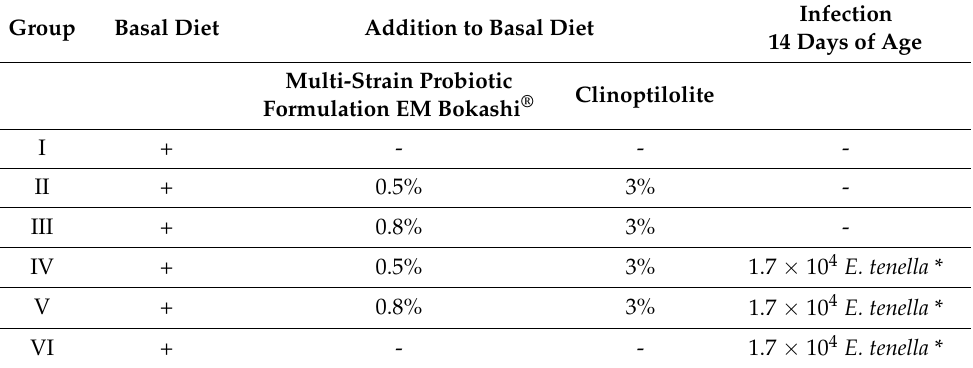
Table 1. Experimental